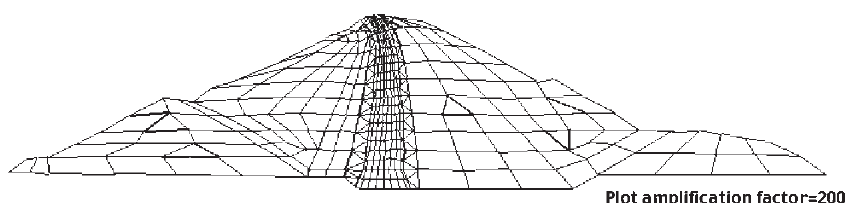
Fig. 10. Deformed mesh geometry of the El Infiernillo Dam after the 14/03/1979 earthquake